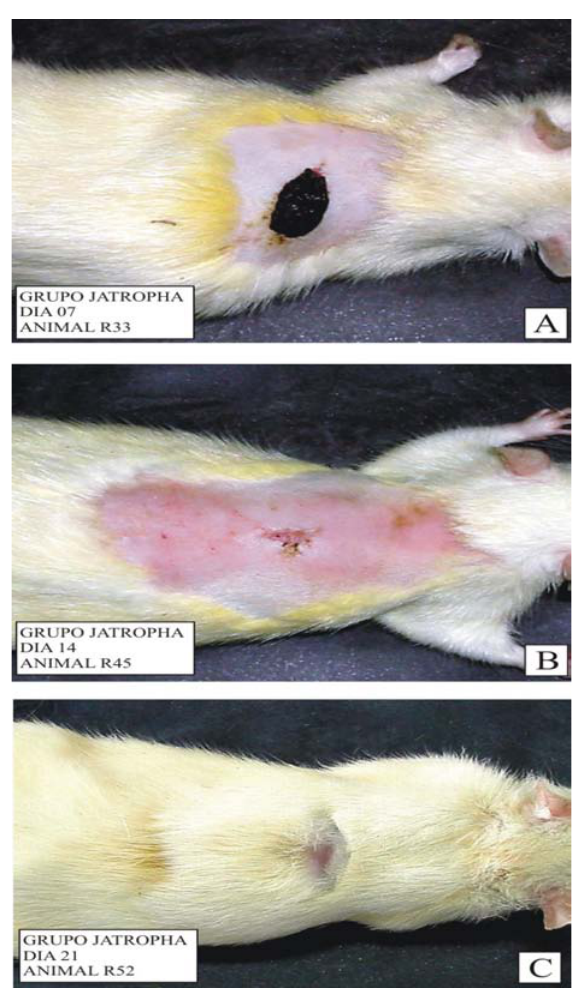
FIGURA 3 - Fotos de animais do grupo Jatropha mostrando as lesões cutâneas no 7º (A), 14º (B), 21º (C) dias do